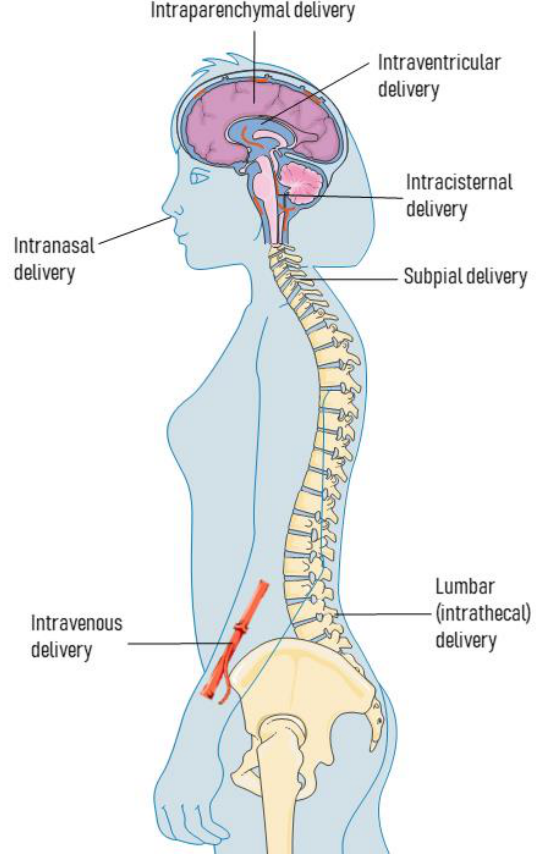
Figure 1. Most commonly used AAV delivery routes for PD. Although the intraparenchymal ap- proach is by far the choice most often used, AAV deliveries can also be implemented through intra-CSF (intraventricular, intracisternal, and intrathecal), intravenous, and subpial